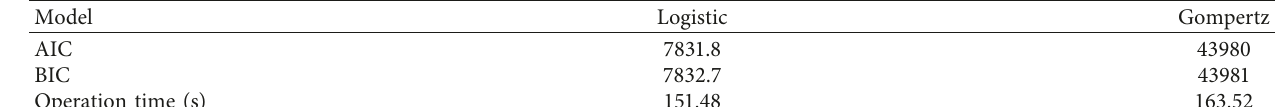
Table 5: AIC, BIC, and operation time of two models.